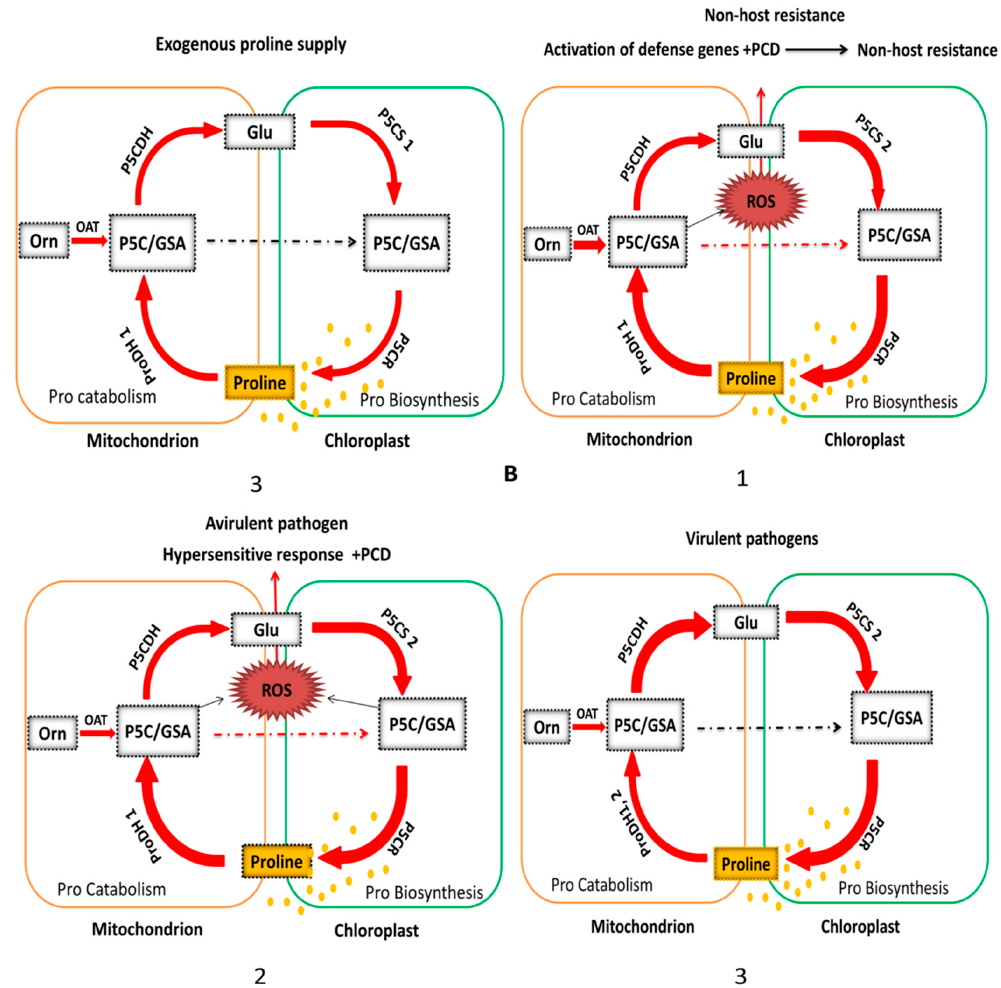
Figure 4. Model for the activation of stress-related genes under different stress environments in plants. There are two groups of stresses: ( A ) abiotic and ( B ) biotic. This diagram shows the up-regulation and down-regulation of the OAT, pyrroline-5-carboxylate dehydrogenase (P5CDH), pyrroline-5-carboxylate synthase (P5CS), pyrroline-5-carboxylate reductase (P5CR), and Pro dehydrogenase (ProDH) enzymes under different stress conditions. Red indicates up-regulation, blue indicates down-regulation, and the thickness of each arrow shows the extent of up- or down-regulation. Yellow dots indicate Pro, which accumulates either in the cytosol or chloroplast depending on the nature of stress. Dotted red lines show activation of P5CR mediated Pro biosynthesis while dotted black lines show normal interacellular transportation of P5C/GSA. In A1 and A2, down-regulation of ProDH1 results in Pro accumulation during drought and salinity stress. During drought stress, all Pro biosynthesis enzymes are up-regulated and the catabolic pathway is down-regulated to favor Pro biosynthesis. During salinity stress, P5CDH is down-regulated and OAT is up-regulated to increase Pro biosynthesis. In A3 when exogenous Pro is supplied all stress-related genes are up-regulated. In B1 and B2, increased Pro catabolism due to up-regulation of ProDH causes the production of reactive oxygen species (ROS), thus activating defense mechanisms during avirulent and non-host pathogen resistance. In B3, induction of P5CDH expression by virulent pathogens prevents pyrroline-5-carboxylate (P5C) accumulation in mitochondria, and activation of the ProDH gene results in moderate levels of Pro accumulation, reducing cell death during infection. Additionally, OAT expression is increased during non-host pathogen resistance, causing increased production of ROS, which in turn activates the hypersensitive response and other defense responses. PCD: programmed cell death.